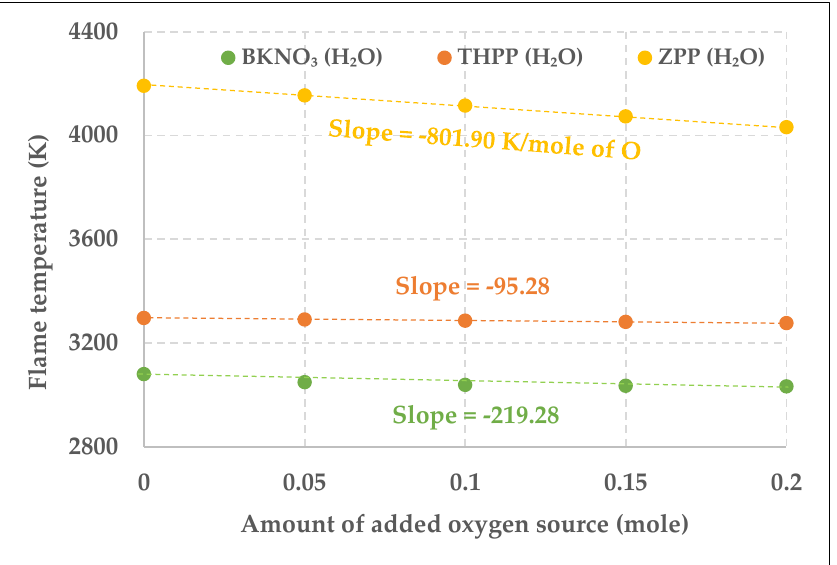
Figure 4. Comparison of the flame temperature decrease with H 2 O addition among THPP, ZPP, and BKNO 3 .